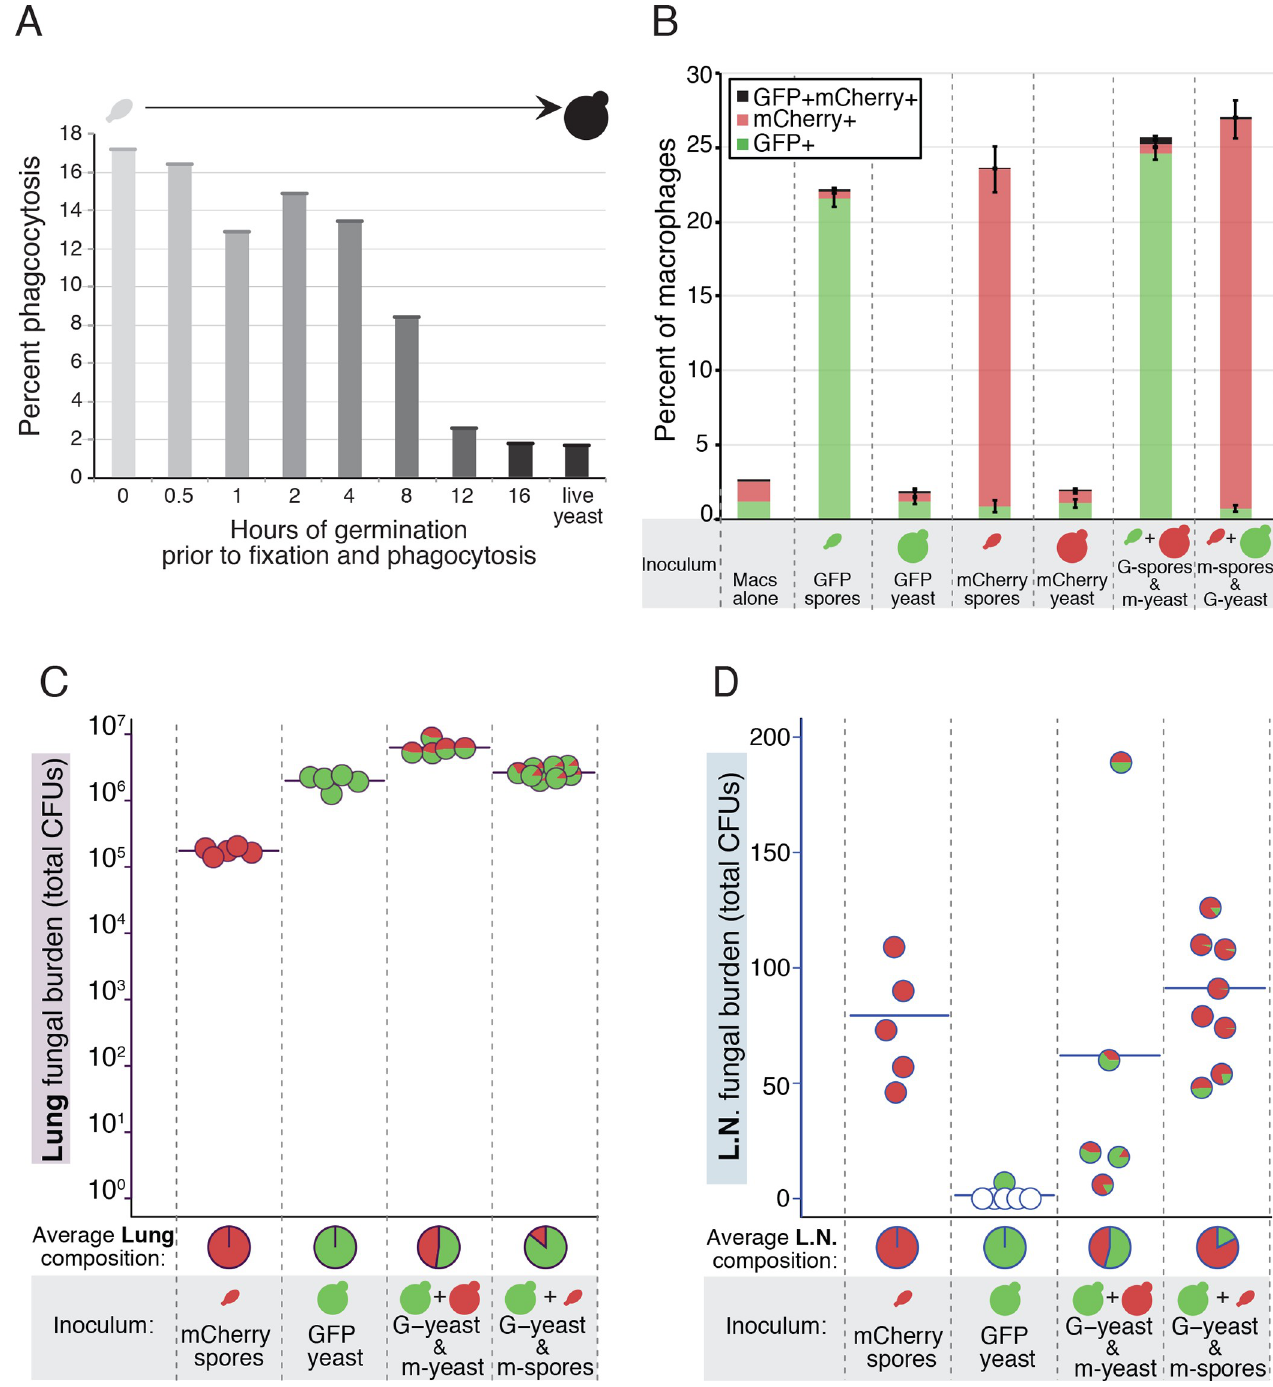
Fig 5. Spore phagocytosis and lymph node dissemination are dependent on intrinsic spore properties. (A) Phagocytosis of formaldehyde-fixed spores by RAW 264.7 macrophages at various points in germination (germination progression indicated by increasingly darker shading). Data are representative of multiple, independent (3) biological replicates. (B) Phagocytosis of spores and/or yeast expressing GFP or mCherry (incubated individually or together) by RAW 264.7 macrophages in vitro. Results are illustrated as stacked bar graphs showing the mean ± SEM percent of macrophages containing mCherry-positive fungal cells (red), GFP-positive fungal cells (green) or both (black) (n = 3) after 4 hours of co-incubation. Compositions of the populations incubated with macrophages are represented below the plots (G = GFP, m = mCherry). (C) Fungal burden quantity and composition in the lungs 3 days post-infection in mice infected with 5x10 6 mCherry-spores, 5x10 6 GFP-yeast, mCherry-yeast and GFP-yeast (5x10 6 of each), or mCherry-spores and GFP-yeast (5x10 6 of each). The results are expressed in jitter plots of pie-charts with the position of each pie chart indicating the fungal burden identified in a single mouse (y-axis). The